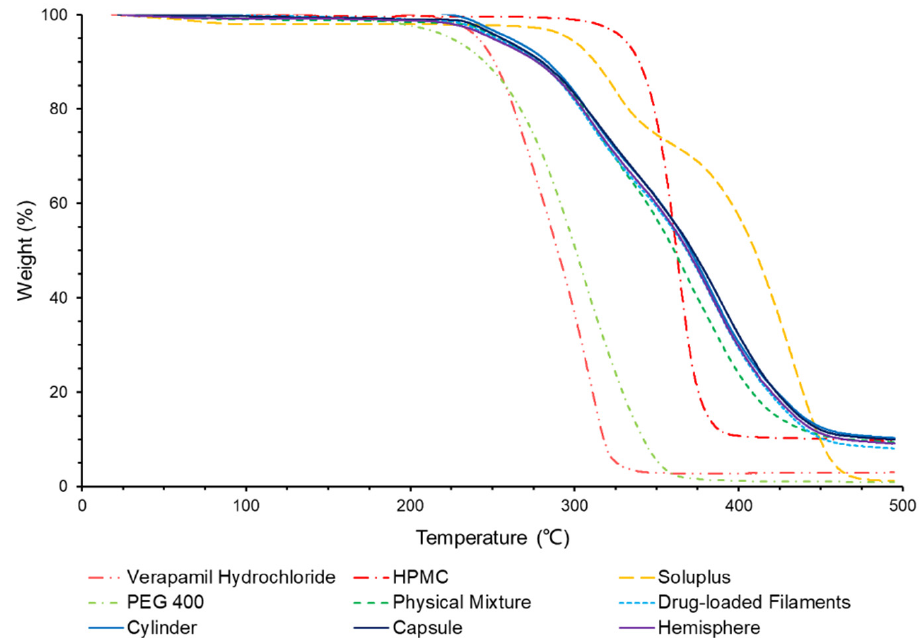
Figure 7. TGA results of verapamil hydrochloride, HPMC, Soluplus, physical mixture, drug-loaded filaments and formulations.